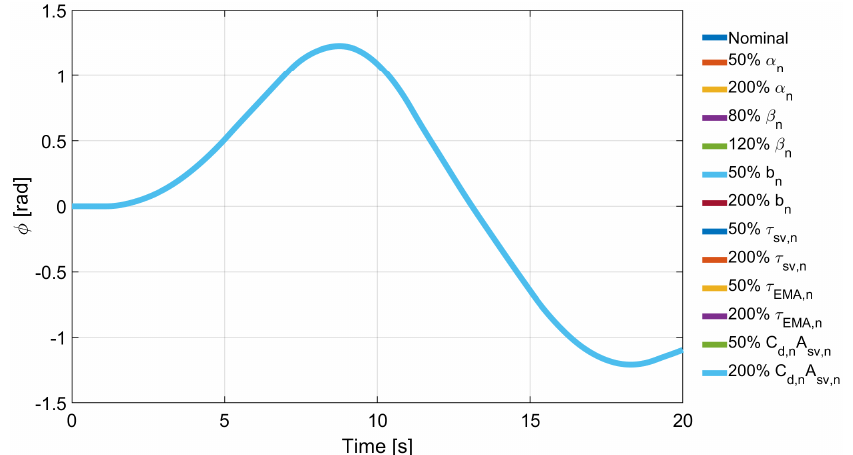
Figure 22. Simulation #3: Roll Angle from the Aircraft Simulator.